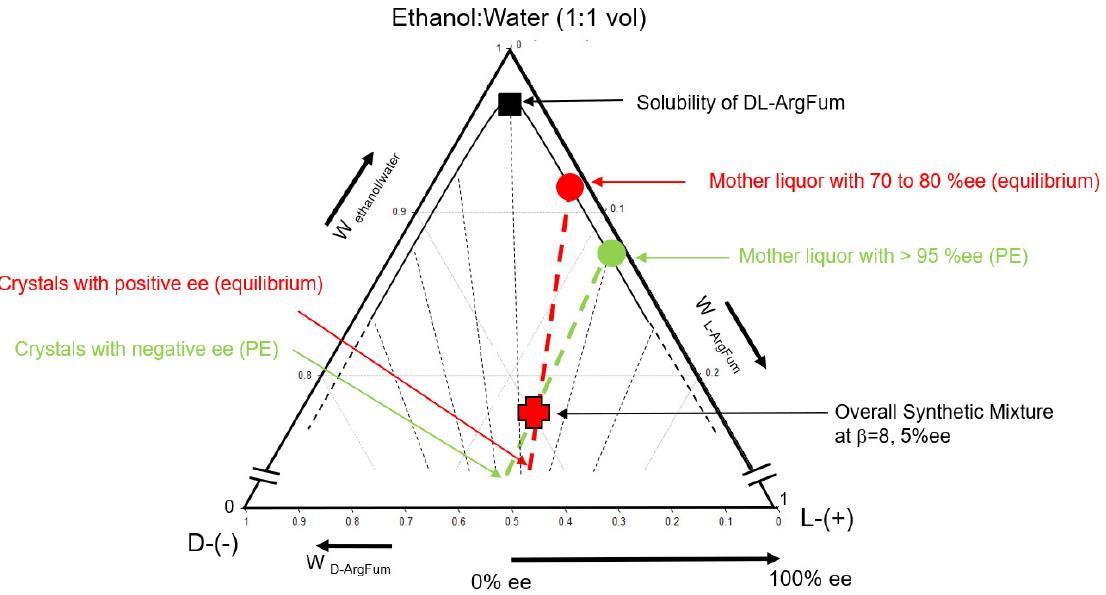
Figure 2. Pseudo-ternary isotherm (T = 5 °C) between L-ArgFum, D-ArgFum and a 50:50 mixture between ethanol and water. The shape of the solubility curve and the size of the solid solution are hypothetical. The composition of the polysaturated solution could not be determined due to too high a concentration. The solubility of the pure anhydrous enantiomers could not be determined due to rapid recrystallization of the hydrated form.